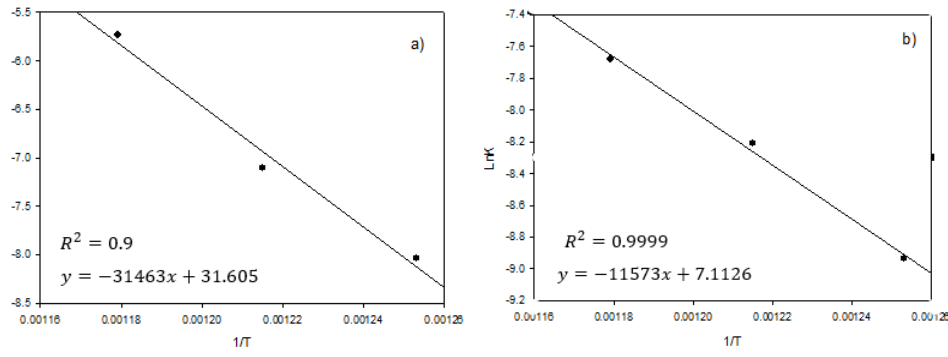
Figure 8. Relationship of ln k versus 1/T using the Arrhenius equation for ( a ) diffusion and ( b ) nucleation and growth.